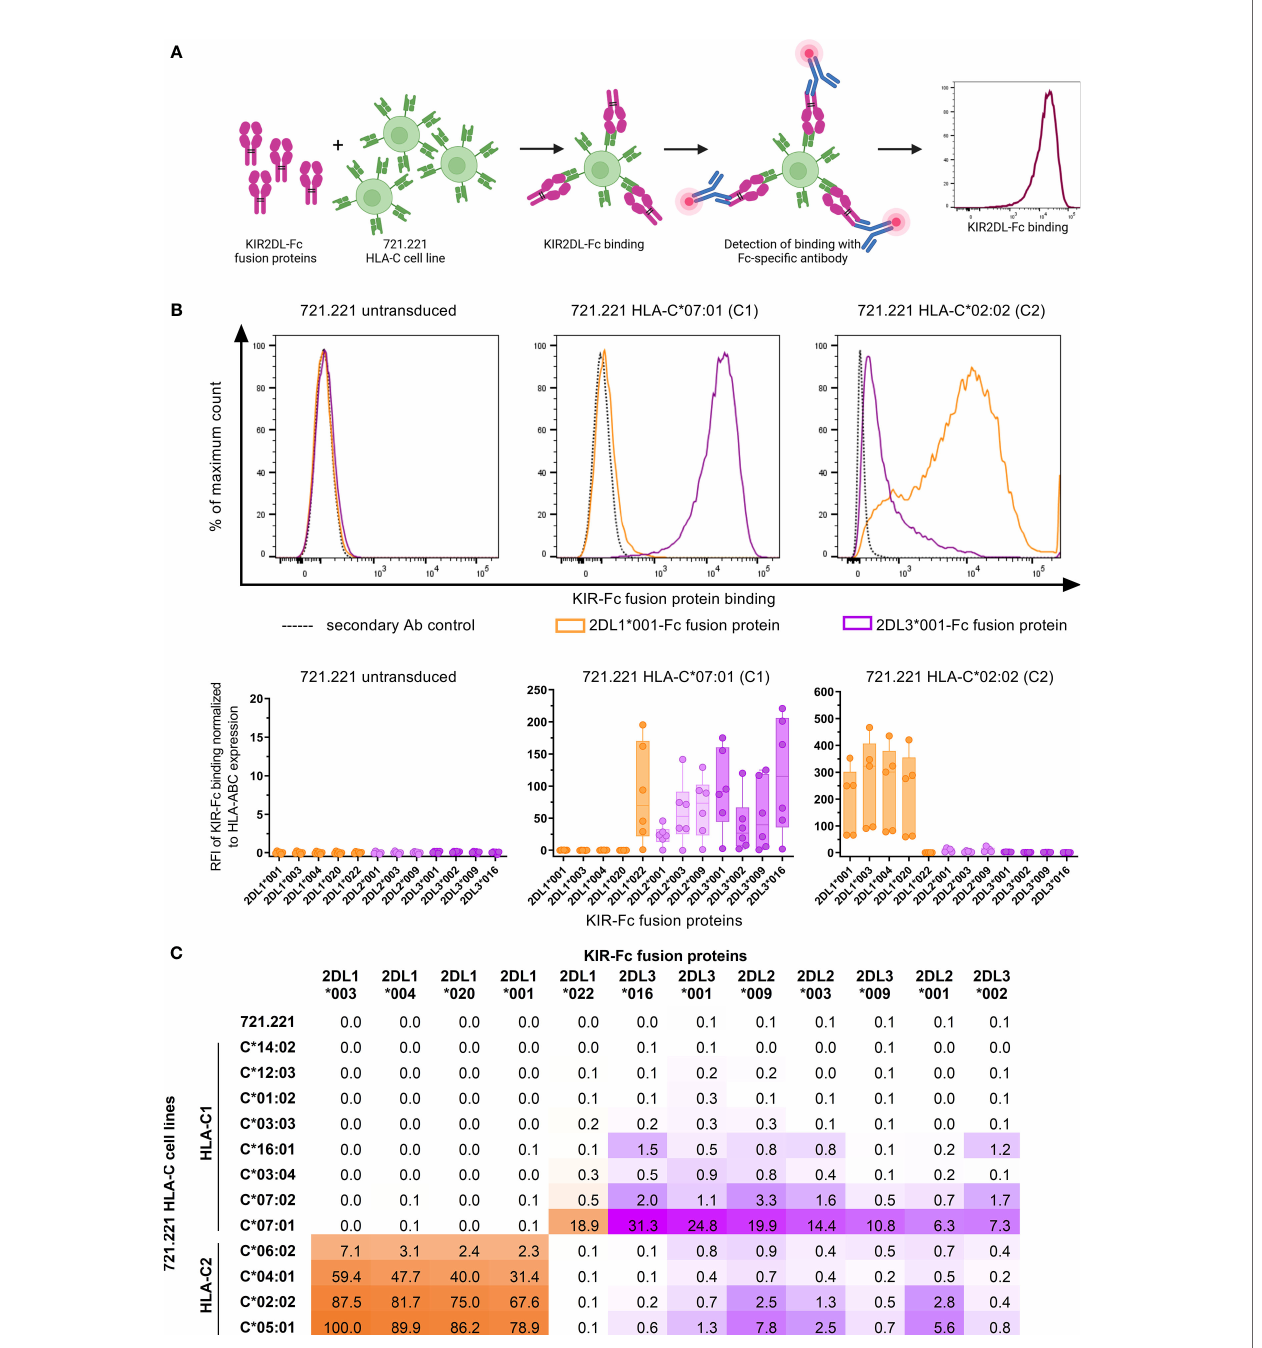
FIGURE 1 | KIR2DL-Fc fusion proteins display differential binding af fi nities to HLA-C expressing 721.221 cell lines. (A) Overview of the assessment of binding af fi nities between HLA-C expressing 721.221 cell lines and KIR2DL-Fc fusion proteins using fl ow cytometry. Created with BioRender.com. (B) Upper panel: Representative histograms depicting binding of KIR2DL1*001-Fc (orange), KIR2DL3*001-Fc (purple) and the respective secondary antibody (Ab) control (black, dotted) to 721.221 (.221),.221-C*07:01 (C1) and .221-C*02:02 (C2) cell lines. Expression was quanti fi ed as fl uorescence intensity (x-axis). Lower panel: Cumulative data showing binding of KIR2DL-Fc fusion proteins to .221, .221-C*07:01 (C1) and .221-C*02:02 (C2) cell lines. Binding of KIR2DL1-Fc (orange), KIR2DL2-Fc (light purple) and KIR2DL3-Fc (dark purple) allotypes is displayed as relative fl uorescence intensity (RFI) normalized to the secondary antibody only control and adjusted for HLA-ABC expression of the respective 721.221 cell lines. Box plots show median and 25%/75% percentile. Data points represent at least fi ve technical replicates (n ≤ 6). (C) Summarizing results of binding assays between 12 KIR2DL-Fc allotypes and .221s expressing 12 different HLA-C allotypes. Highest binding value was set to 100% and all other values were calculated in relation to the 100%